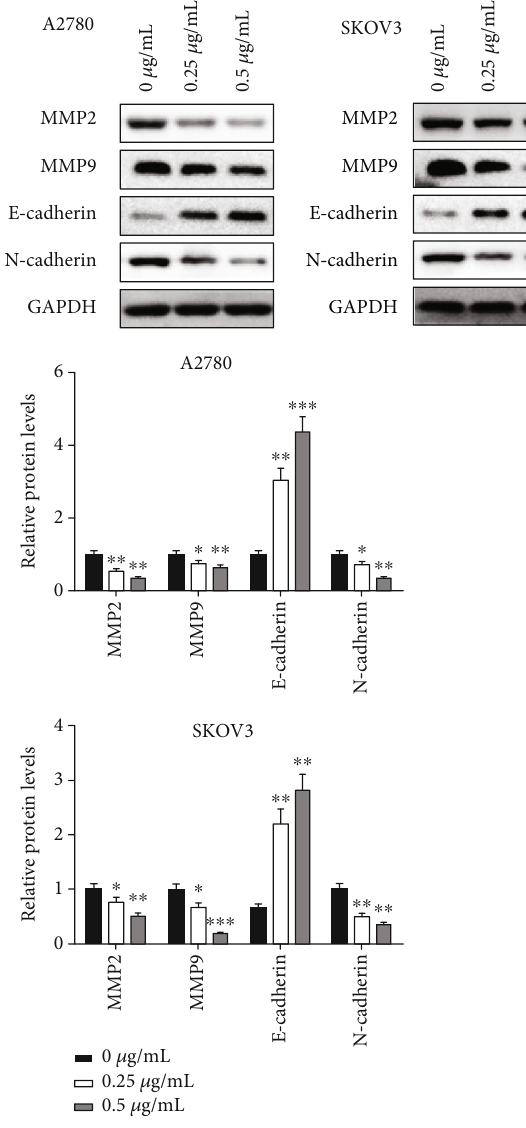
Figure 4: The e ff ects of SLT on migration, invasion, and EMT of ovarian cancer cells. (a) The e ff ects of SLT on cell migration were detected by wound healing assay in A2780 and SKOV3 cells (magni fi cation × 20; scale bar = 1000 μ m ). (b) The e ff ects of SLT on cell invasion were evaluated by Transwell assay (magni fi cation × 100; scale bar = 200 μ m ). (c) The e ff ects of SLT on the expression levels of EMT-related protein in A2780 and SKOV3 cells were evaluated via western blot assay. The values were displayed as the mean ± SD . Representative results from three independent experiments were shown ( ∗ P < 0 : 05 , ∗∗ P < 0 : 01 , and ∗∗∗ P < 0 : 001 , compared with the control